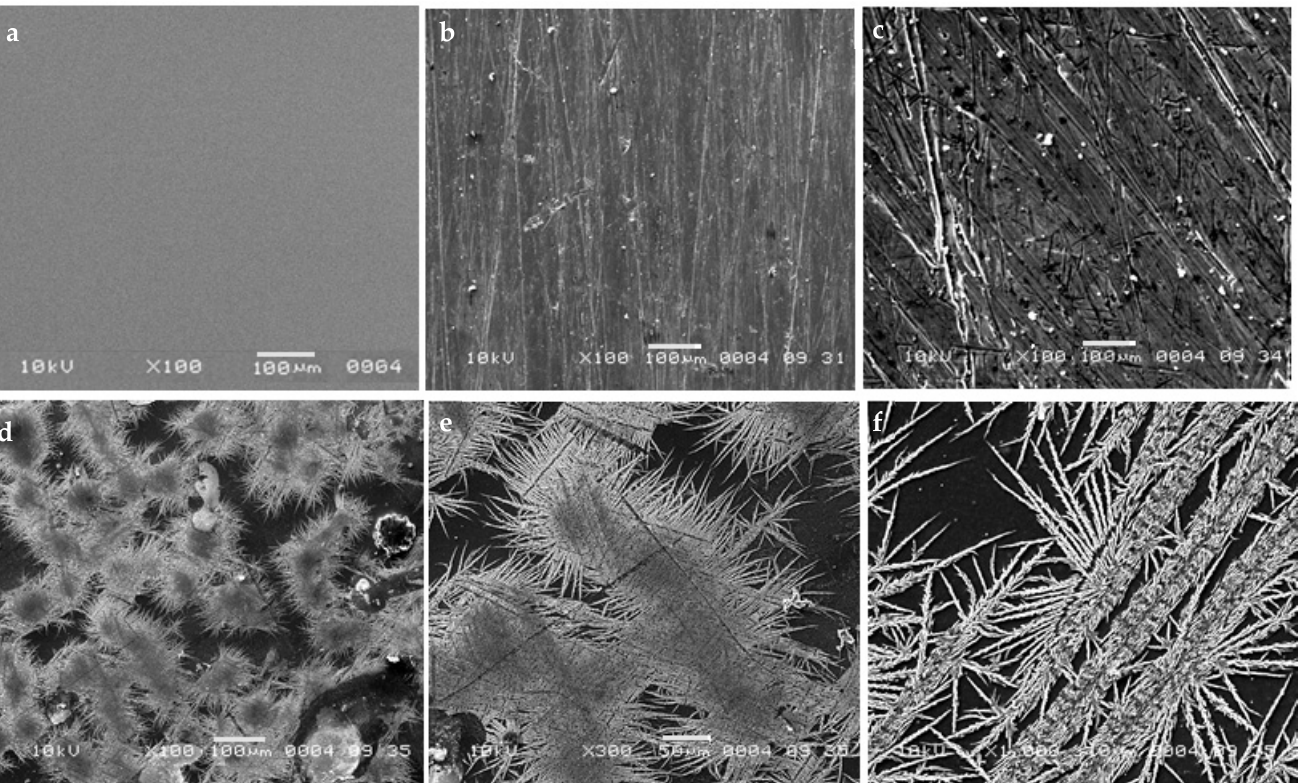
Figure 7. SEM micrographs of PVA/Ag + /NBT control film ( a ) and irradiated PVA/Ag + /NBT films with 4 mGy ( b ), 10 mGy ( c ) and 20 mGy with different magnifications ( d – f ).